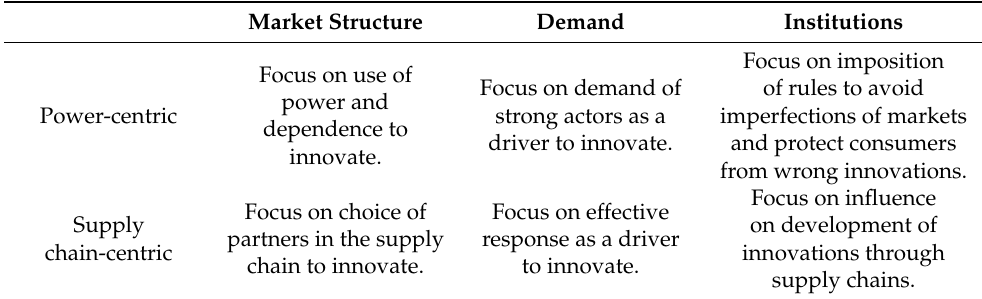
Table 1. Framework for innovation research in the food sector from the perspective of market conditions and power/flow in supply